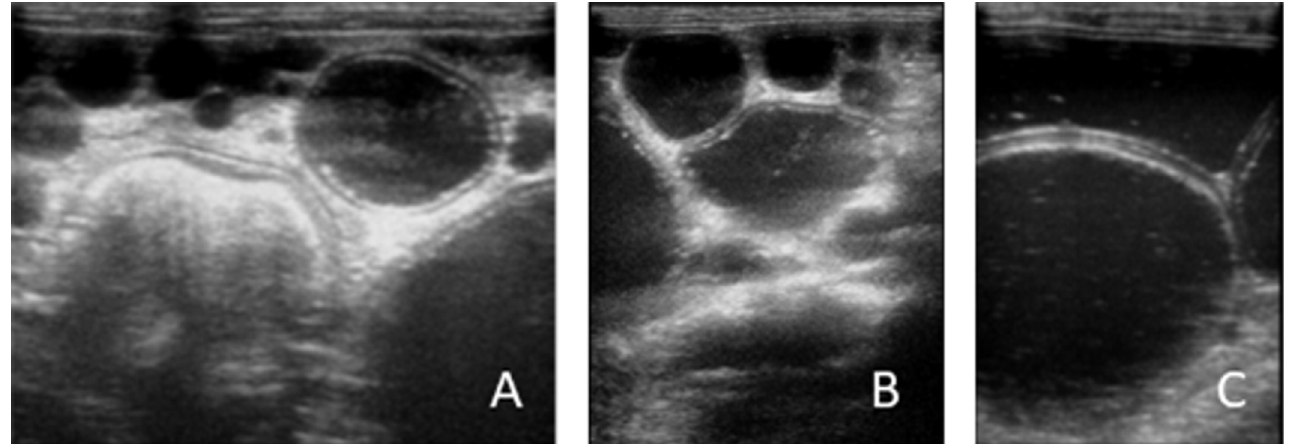
Figure 1. Abdominal ultrasound images. Hydatids either attached to the omentum (A) or apparently free in the peritoneal cavity (B) with anechoic content and delimited by a hyperechoic rim. Particular of a large peritoneal hydatid with evident bilaminated structure of the wall appearing as a double echogenic line separated by a hypoechogenic space